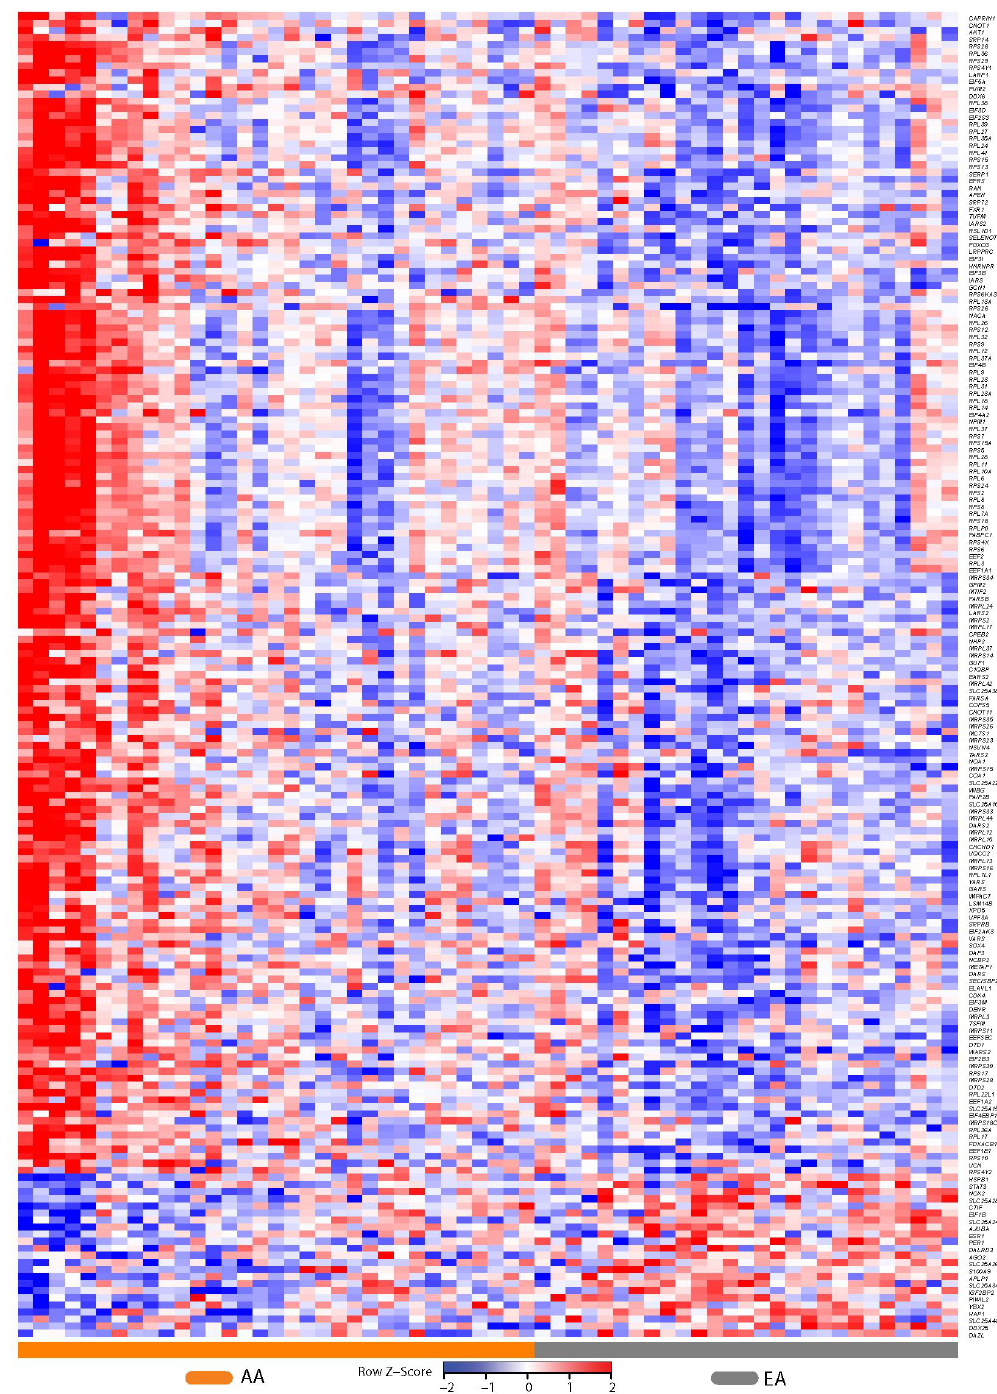
Figure 7. Heatmap of the 187 shared gene signatures derived from the GO terms RNA binding, structural constituent of ribosome, SRP-dependent co-translational protein targeting to membrane and the biological pathways translation, L13a-mediated translational silencing of Ceruloplasmin expression. Red and blue boxes depict relative over- and under- expression with regard to a reference set as the mid-point between all patients. Only significant transcripts ( q < 0.1) are shown. A cluster of five AA patients is visible at the extreme left of the